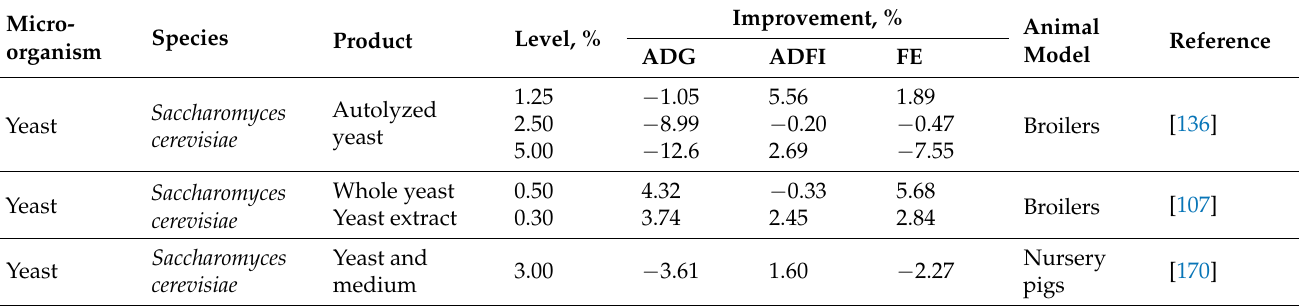
Table 7. Single-cell proteins from yeasts and their impacts on growth